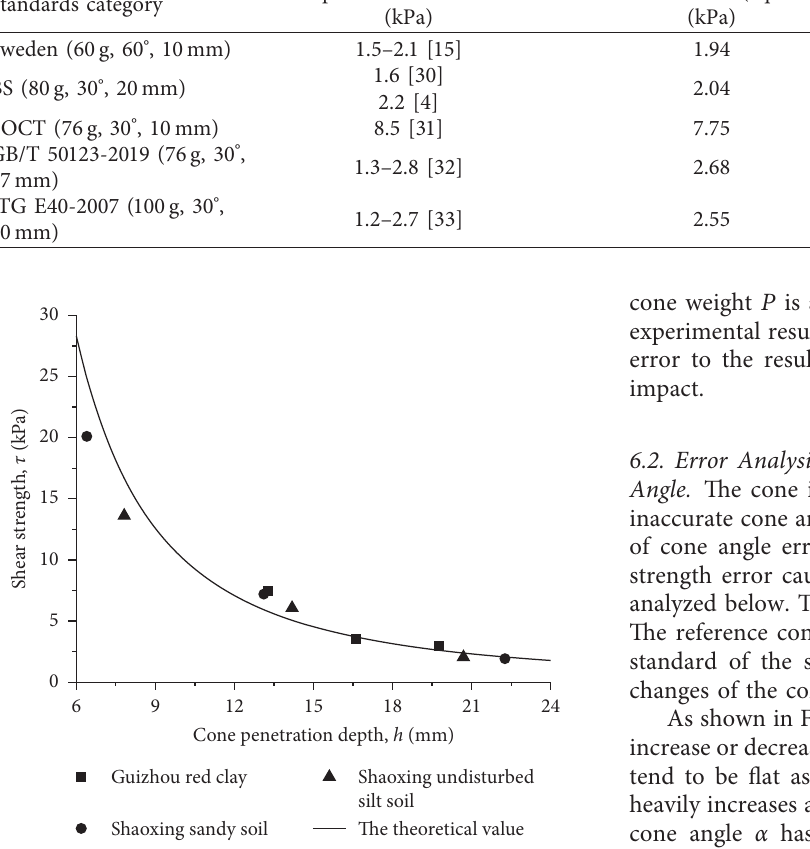
Figure 4: Comparison of experimental and calculated values of shear strength τ